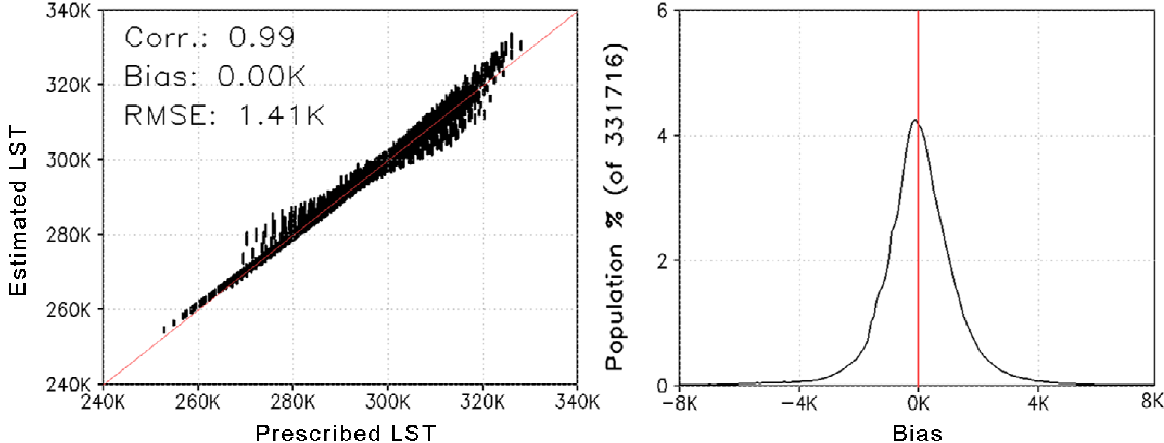
Figure 3. Scatter plot ( left ) of prescribed land surface temperature (LST) and estimated LST using the database simulated by Moderate Resolution Atmospheric Transmission version 4 (MODTRAN4) for the full range of conditions; histogram ( right ) of the difference between the prescribed LST and estimated